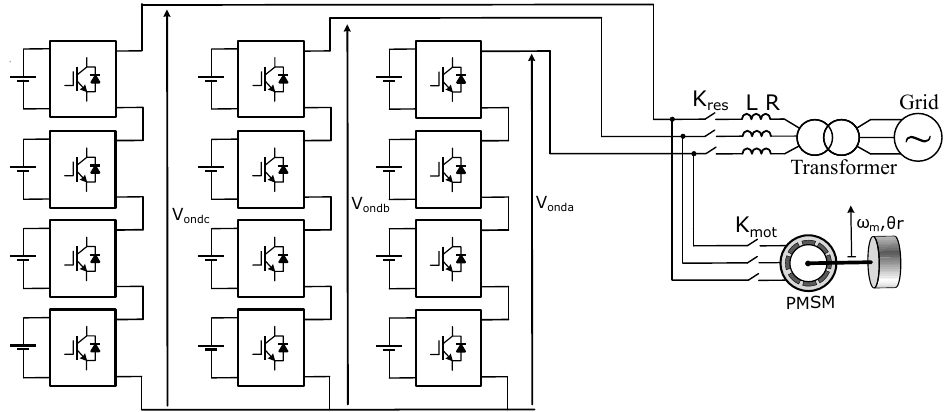
Figure 15. Bidirectional battery charger using multilevel modular